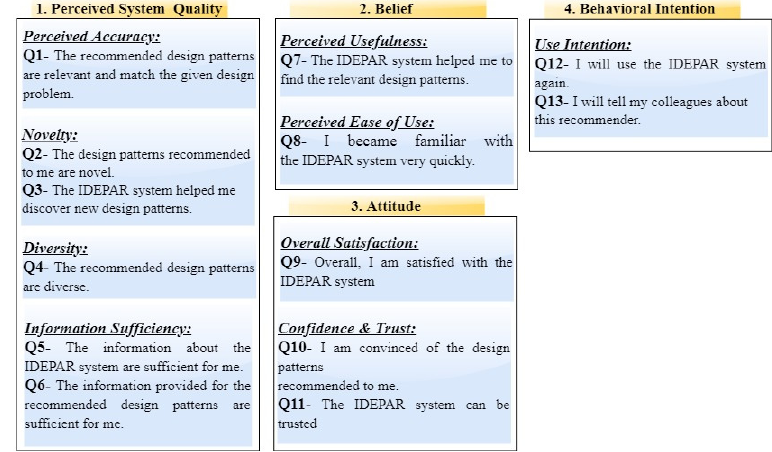
Figure 18. Representative Questions from each ResQue layer.